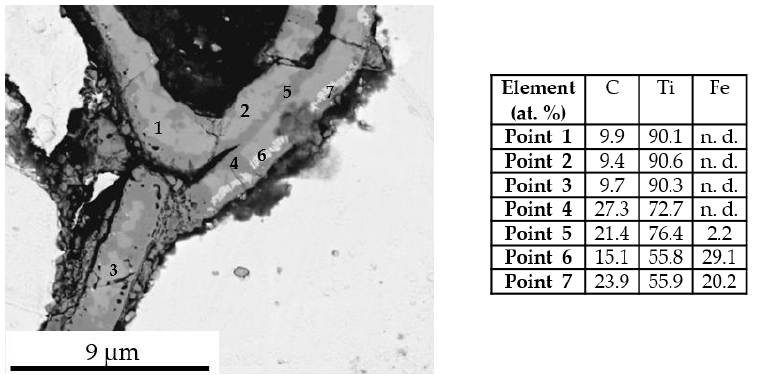
Figure 10. SEM image (backscattered electrons mode) and EDX analyses inside the 1.5 µm thick Ti coating after sintering.